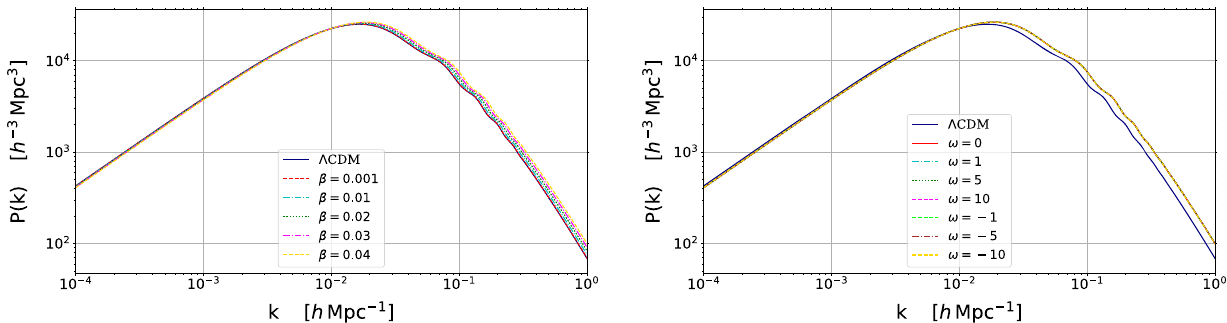
Fig. 2 Matter power spectra diagrams for different values of β compared to (cid:3) CDM model, considering ω = 0 (left), and analogous diagrams for different values of ω , where β = 0 . 04 (right)